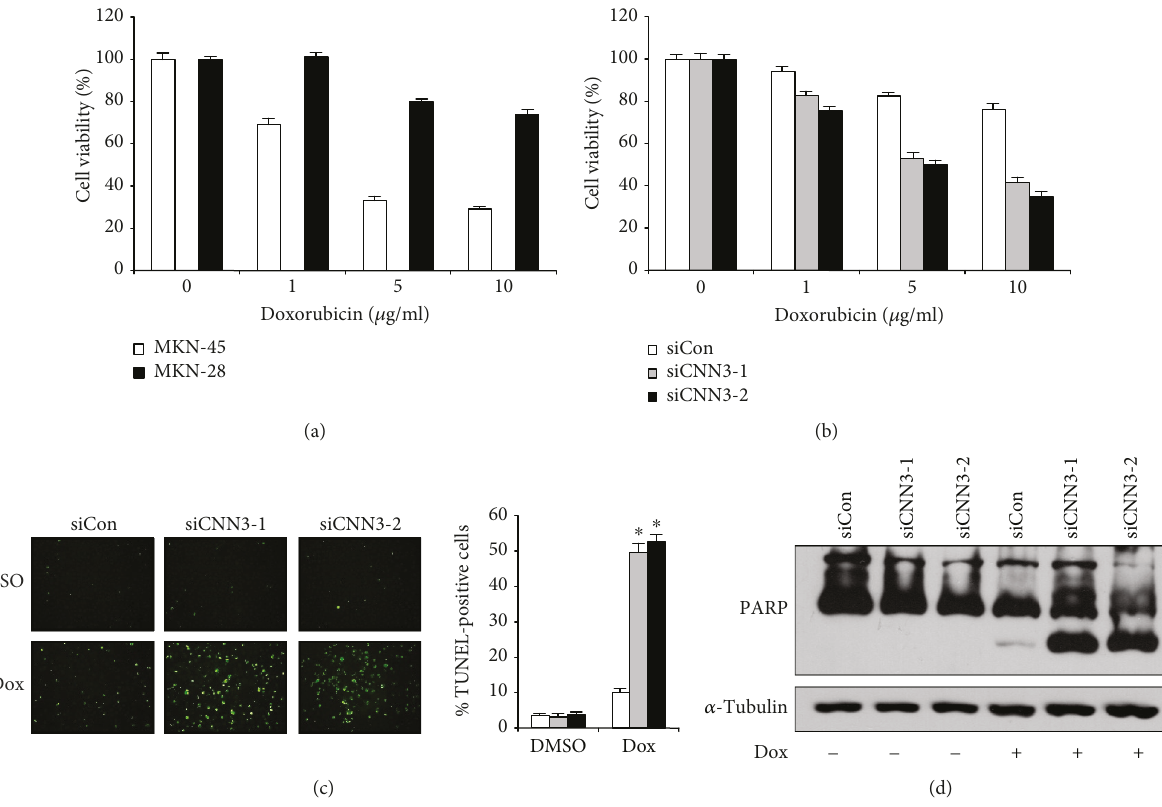
Figure 3: CNN3 is critical for doxorubicin resistance in MKN-28 cells. (a) Viability of two di ff erent human gastric cancer cell lines (MKN-28 and MKN-45) after treatment with the indicated concentrations of doxorubicin for 48h. (b) Viability of control siRNA- and CNN3-speci fi c siRNA-transfected MKN-28 cells after treatment with the indicated concentrations of doxorubicin for 48 h. (c) Representative images for TUNEL staining of CNN3-depleted MKN-28 cells after doxorubicin (Dox) treatment (2 μ g/ml) for 24 h. The histogram shows the ratio of TUNEL-positive CNN3-depleted MKN-28 cells after Dox treatment (2 μ g/ml) for 24 h. The data shown are expressed as the means ± SD of three individual experiments, each performed in triplicate. ∗ P < 0 01 as determined by t -test. (d) Representative immunoblot for PARP cleavage in control siRNA- and CNN3-speci fi c siRNA-transfected MKN-28 cells after Dox treatment for